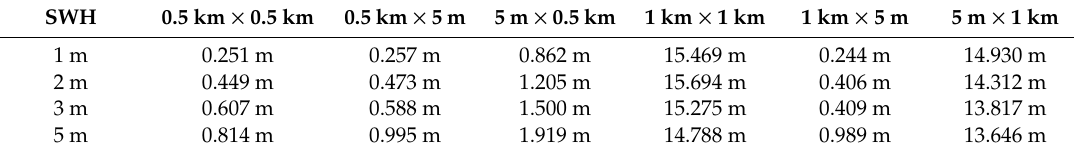
Table 18. The RMS of smoothing layover phase results with di ff erent SWH (the direction of the smoothing window is in two directions at the same time, in the azimuth and in the range).